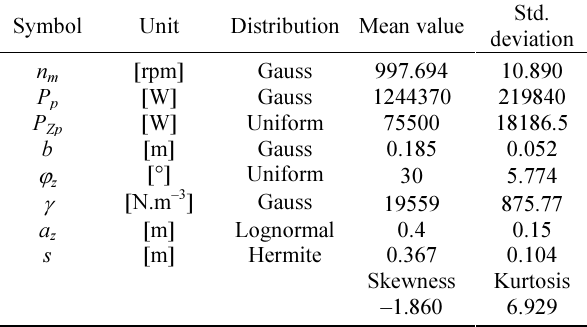
Table 4. Random variables for the third terrace Symbol